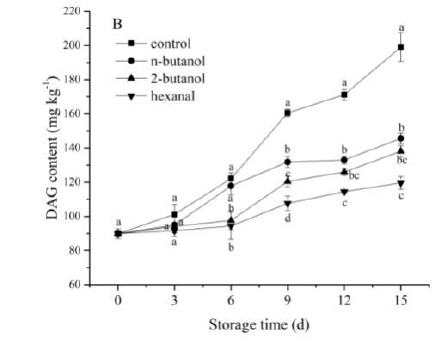
Figure 4. Effect of phospholipase D inhibitors treatment on cell membrane PA content ( A ), DAG content ( B ), PC content ( C ), and PI content ( D ) of postharvest banana fruit in response to mechani- cal wounding stress. The vertical bars in each mean indicate the standard error ( n = 3). Different letters among treatments at the same time point indicate significant differences ( p < 0.05). 4. Discussion PLD has been implicated in the response of plants to wounding. Previous work has conclusively demonstrated that the activation of PLD may also play a key role in mediat- ing wound-induced lipid hydrolysis [8]. The regulation of PLD activity can significantly affect postharvest fruit quality. Different PLD inhibitors, such as primary alcohols, N- acylethanolamine, and lysophosphatidyl ethanolamine [32,33], have been used in PLD re- search. The regulation of PLD activity may have important impacts on the maintenance of quality of postharvest fruit. Several PLD inhibitors, such as 2-butanol, n-butanol, and hexanal, can preserve the physiological quality of postharvest fruits, thereby prolonging their shelf life [19,21,22,34]. Particular features of banana ripening and senescence are the decrease in fruit firmness and changes in sugar contents, which are regulated by respira- tion. The present study showed that PLD inhibition with 2-butanol, n-butanol, and hex- anal maintained firmness inhibited the increase in TSS and reduced the respiration rate, especially after day 9 (p < 0.05). Among the three treatments, the hexanal-treated sample presented the highest firmness, as well as the lowest TSS content and respiration rate on day 15, suggesting that hexanal maintained the best quality of banana fruit by delaying organic matter consumption and ethylene-induced senescence. Thus, the data indicated that hexanal treatment suppressed fruit softening and the occurrence of climacteric respi- ration peaks, and was effective in delaying ripening and preserving the postharvest qual- ities of banana fruits. Previous studies have conclusively indicated the beneficial effects of hexanal on several fruits and vegetables, such as tomato [15,20], apple [35], mango [36], and strawberry [37]. These studies demonstrated that hexanal improved the shelf life and visual attributes, without impaired fruit color or compromised flavor characteristics, which effectively enhanced the shelf life and quality [38,39]. Cell membrane permeability and MDA are indicators of lipid peroxidation and can reflect lipid peroxidation extent induced by oxidative stress [40]. A gradual increase in cell membrane permeability and MDA accumulation of banana fruit was observed during